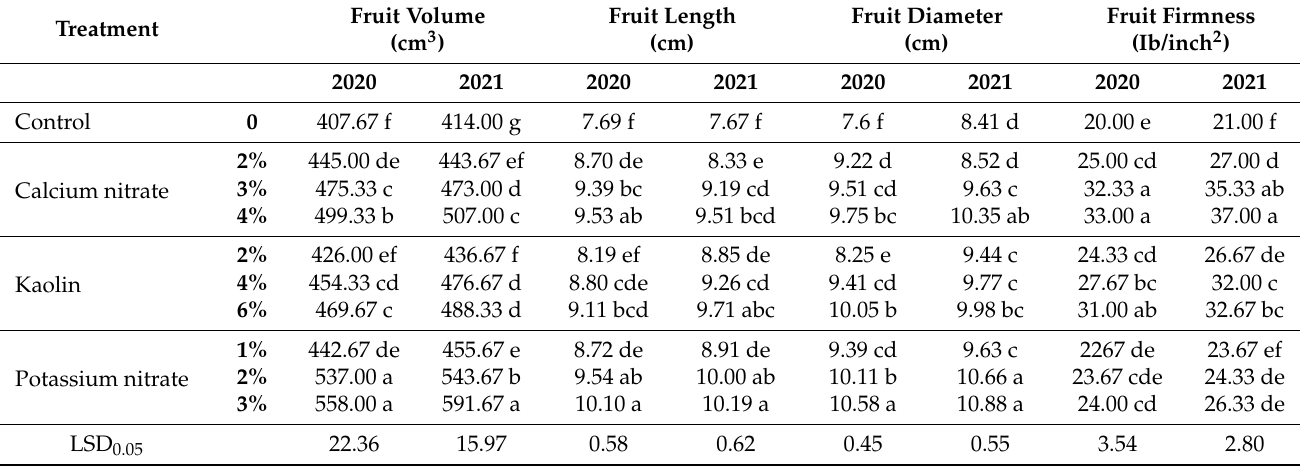
Table 4. The effect of the foliar application of potassium nitrate, calcium nitrate and kaolin on the fruit volume, length, diameter and fruit firmness of ‘Wonderful’ pomegranates during the 2020 and 2021